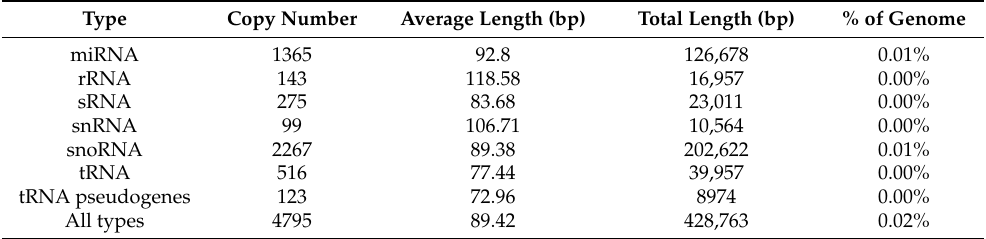
Table 7. Statistics of non-coding RNA annotation for the M. chilensis genome.